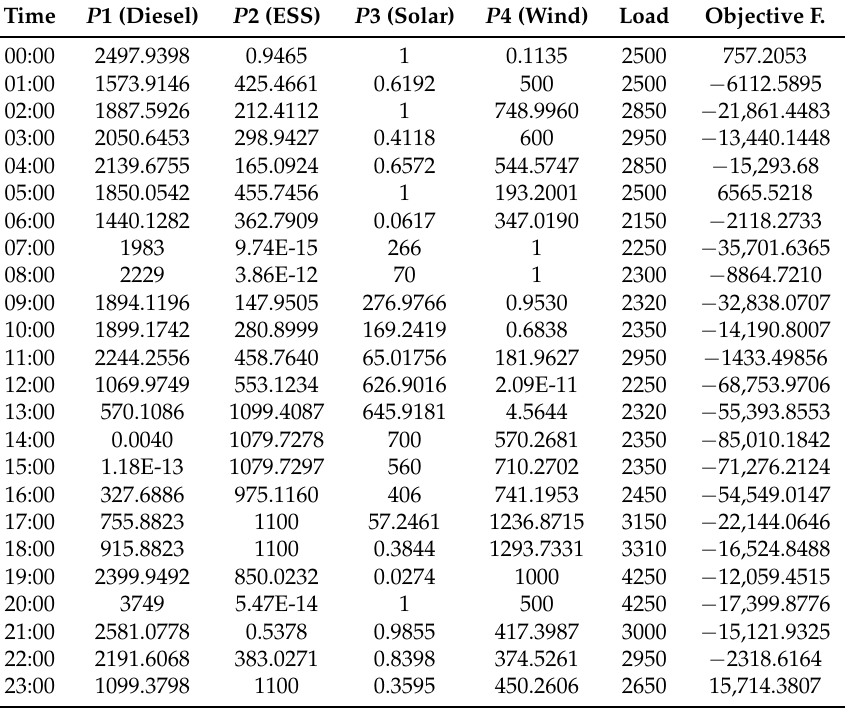
Table 8. Details of the best solution found by the